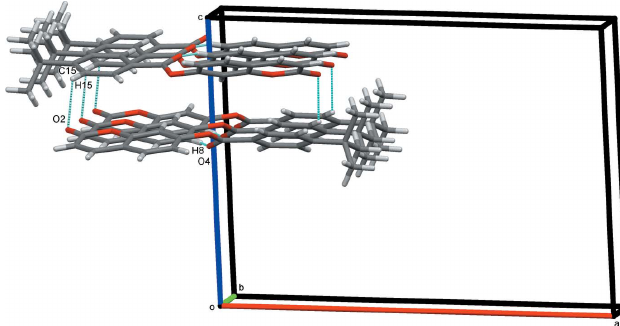
Figure 3 Crystal packing of (I) showing adjacent pairs of molecules along the b